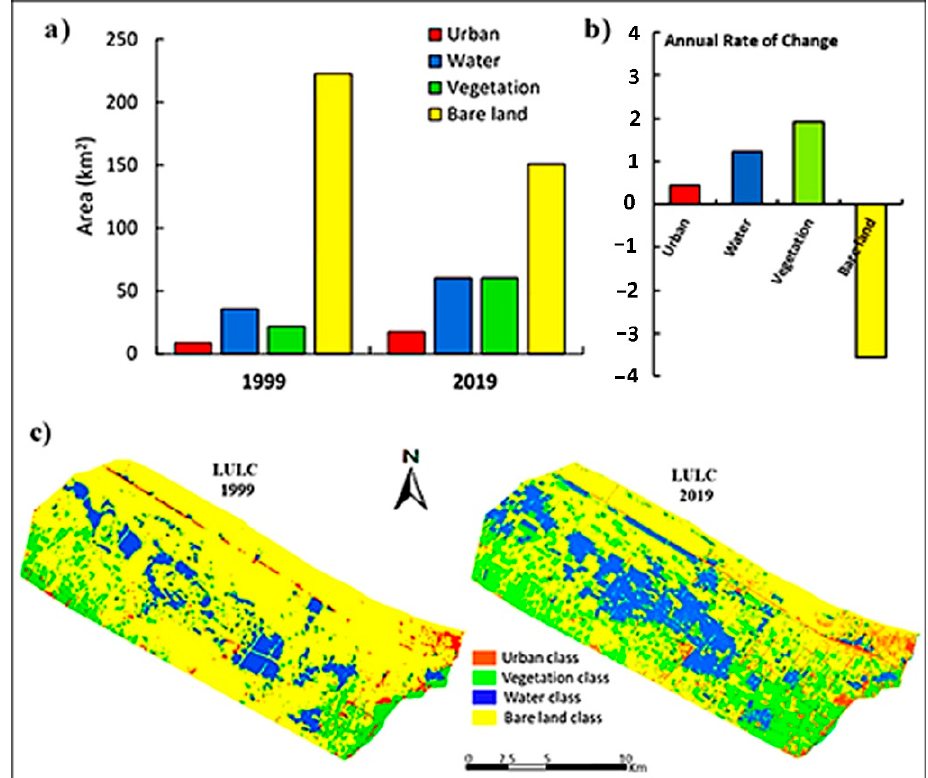
Figure 5. Areas in sq. km of LULC classification for Deltaic Mediterranean Coast of the study area ( a ) classification comparison from 1999 to 2019, ( b ) annual rate of change for each class, and ( c ) LULC distribution map.